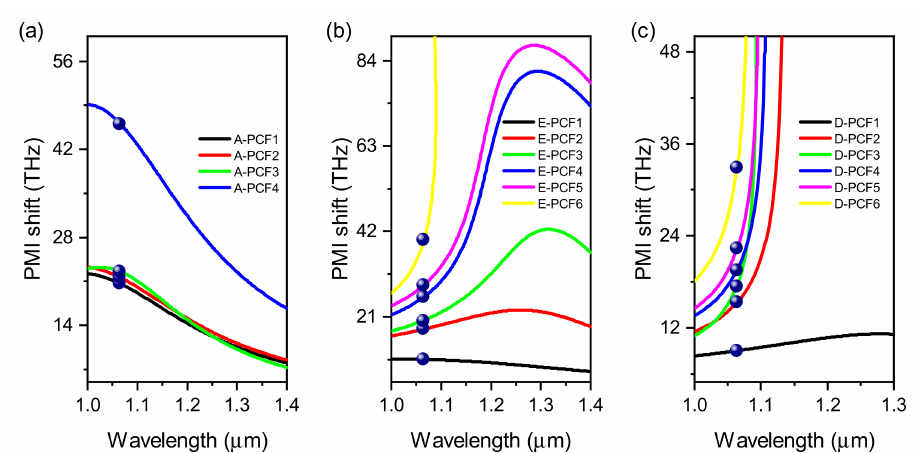
Figure 11. PMI–SF frequency shift as function of pump wavelength calculated for ( a ) air-filled PCFs, ( b ) ethanol-filled PCFs and ( c ) D 2 O-filled PCFs. Dots are experimental data. Peak power of 2.5 kW for air-filled PCFs and 3 kW for both ethanol-filled PCFs and D 2 O-filled